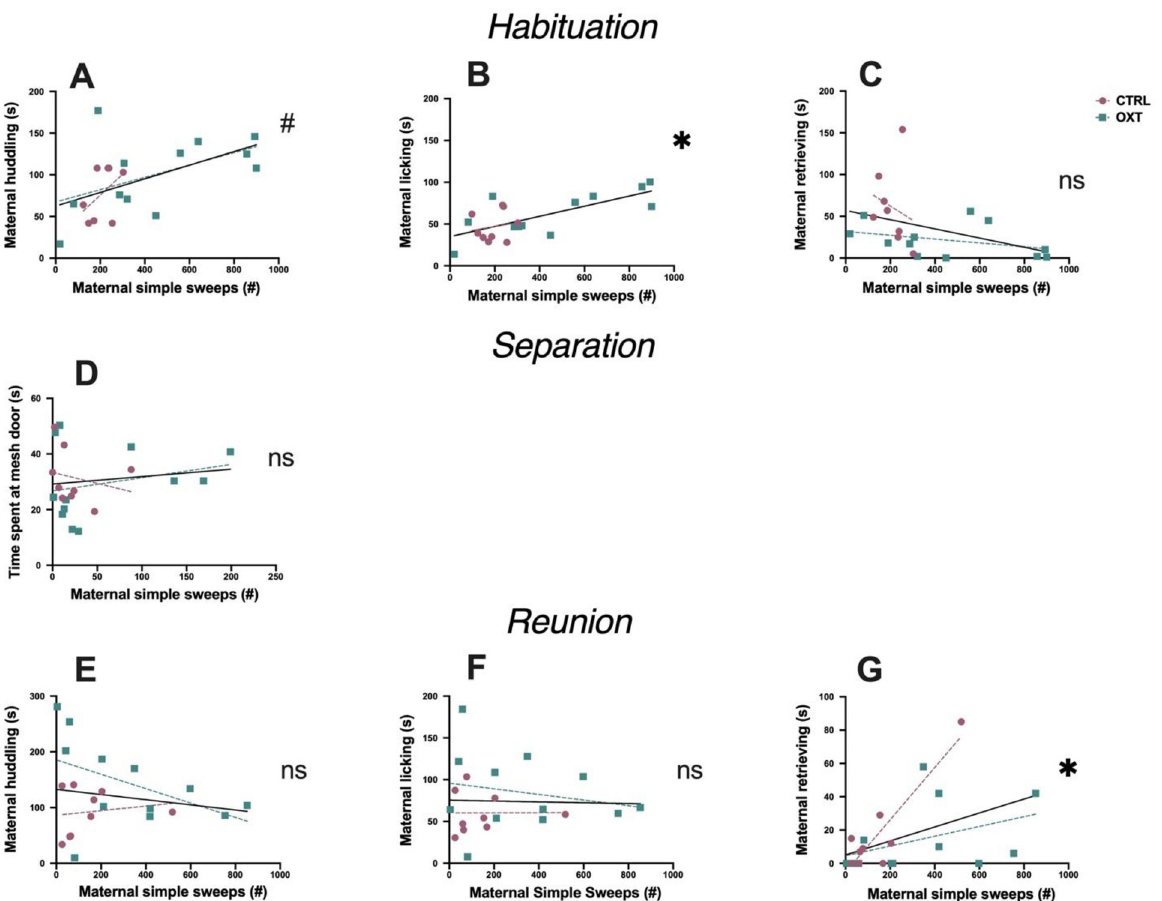
Fig 4. Correlations between maternal simple sweep USVs and maternal care. (A-C) Habituation . (A) There was a nonsignificant trend correlation between maternal simple sweeps and huddling. (B) Maternal simple sweeps positively correlated with licking behavior. (C) Maternal simple sweeps did not correlate with retrieving/carrying. Mothers given IN OXT carried/retrieved pups less than mothers given saline. (D) Separation . There was no correlation between time mothers spent at the mesh divider and maternal simple sweep USVs. (E-G) Reunion . (E) Maternal simple sweeps did not correlate with huddling or (F) licking. (G) Maternal simple sweeps positively correlated with maternal retrievals. Correlation line in black is the average slope across treatment groups; magenta and teal lines are the slopes for the saline and OXT treatments, respectively. � p < 0.05; #p <